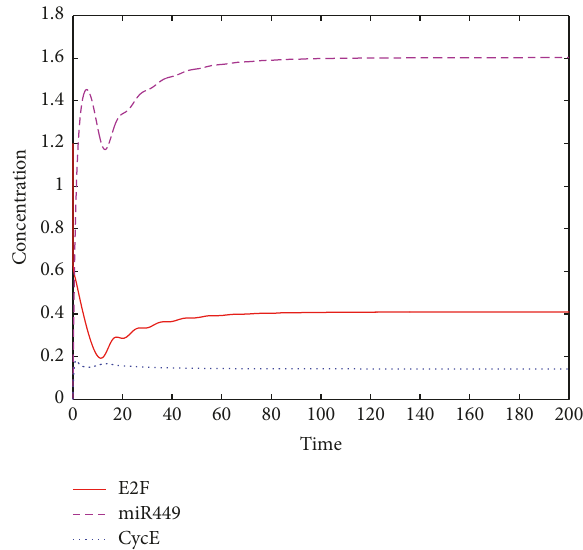
Figure 2: An asymptotically stable equilibrium for 𝜏 = 𝜏 1 = 𝜏 2 = 𝜏 = 0 .Assumeinitialconditionsare 𝑥 3 0, 𝑥 = 0, 𝑥 = 0.55, 𝑥 5 6